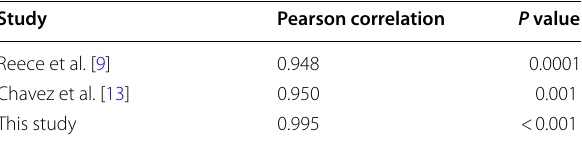
Table 6 Accuracy of TCD with GA-A comparison Study